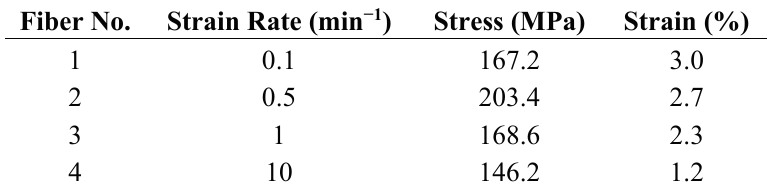
Table 2. Stress–strain average results and the effect of variation on strain rate [5,6].